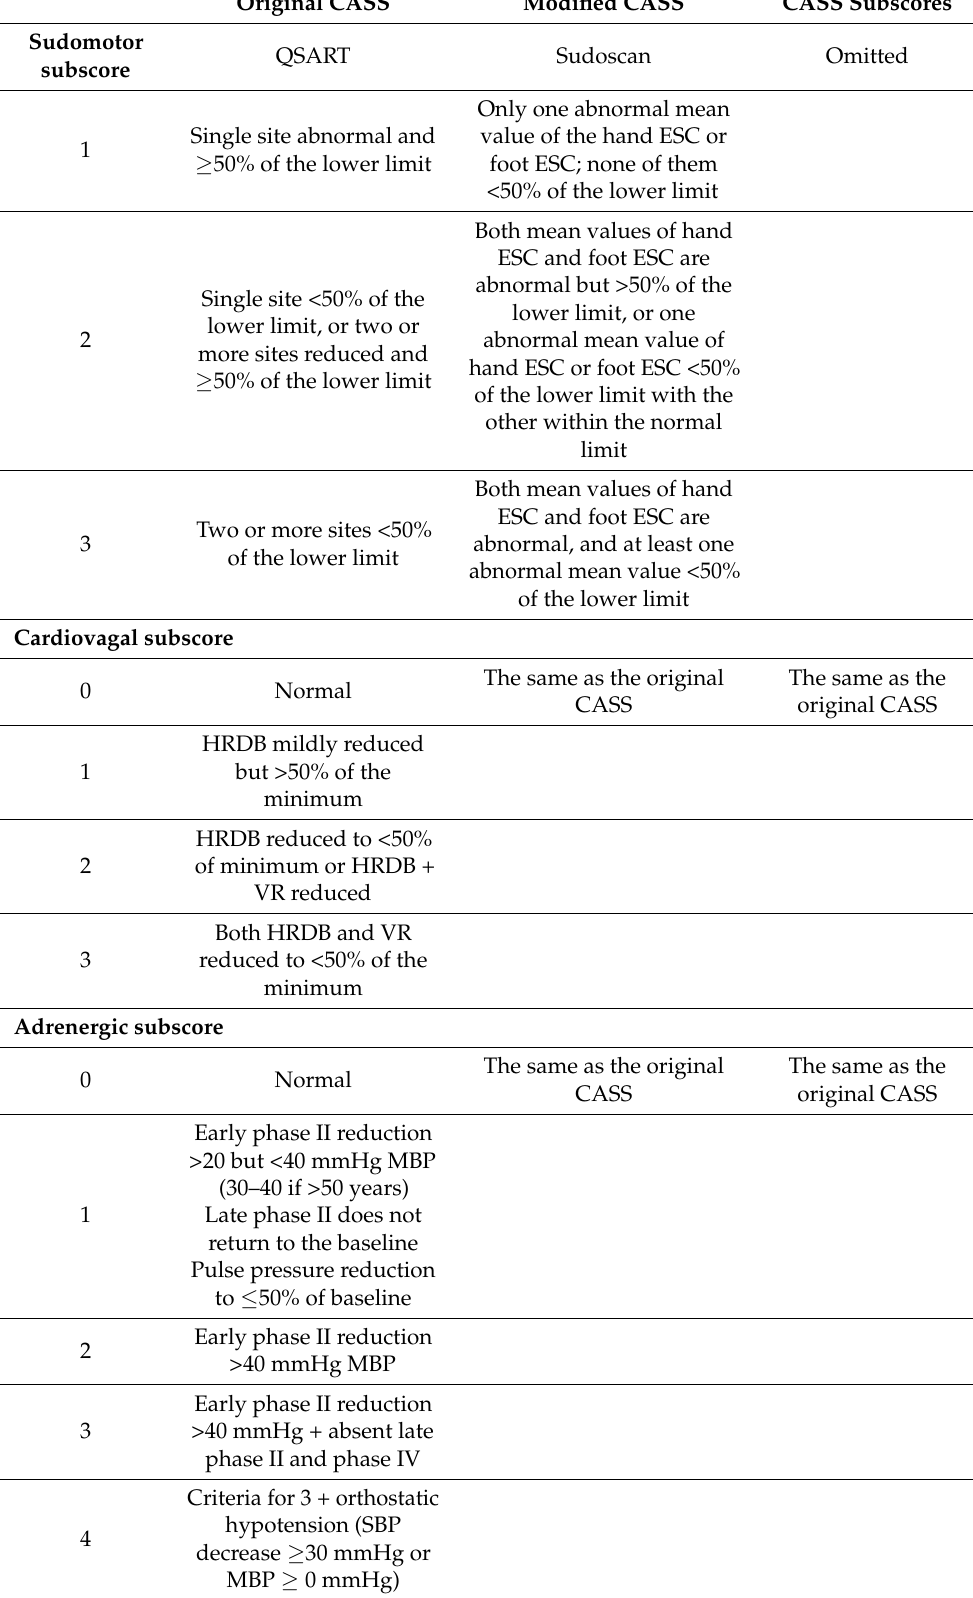
Table 1. Comparison of original CASS, modified CASS, and CASS